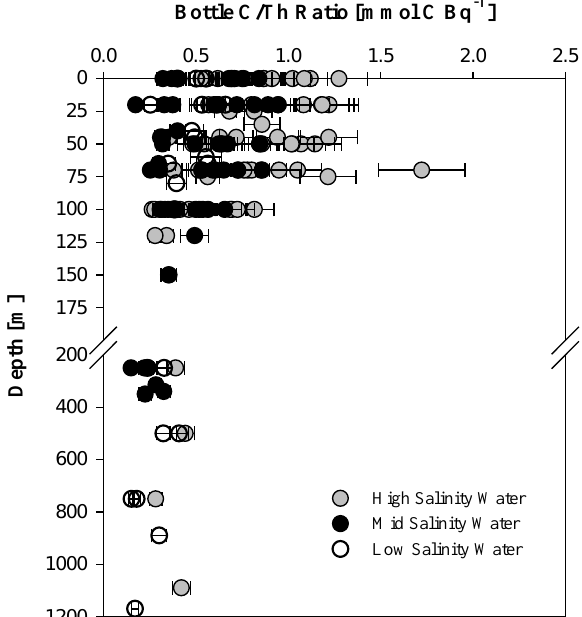
Fig. 8. Profiles of bottled POC/Th ratios for the three water types identified by their salinity differences (see Fig.